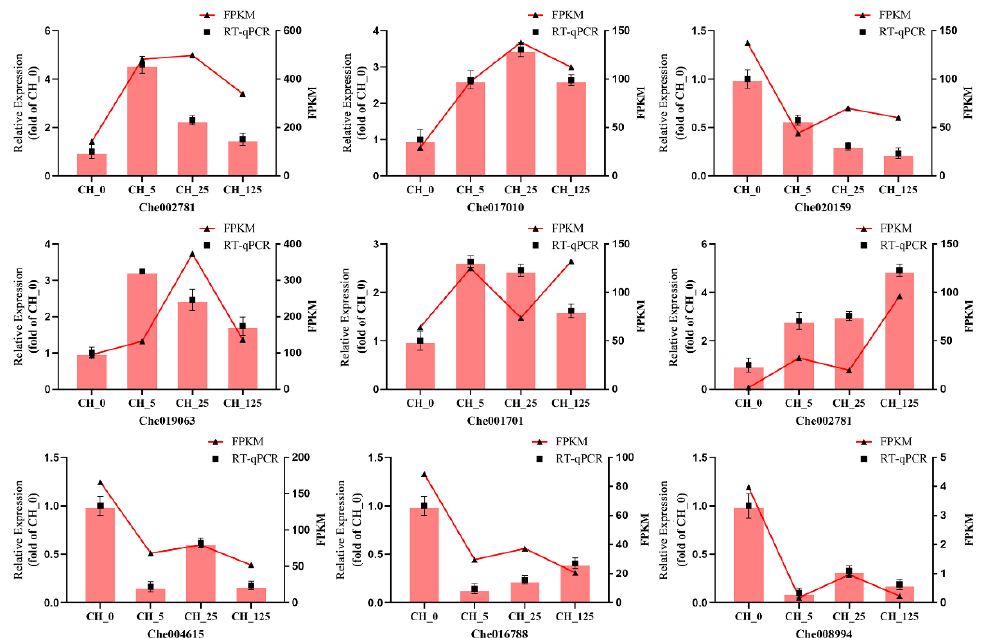
Figure 7. Validation of the expression patterns of differentially expressed genes selected from the RNA-seq analysis by RT-qPCR. The relative gene expression levels determined by RT-qPCR are shown on the left Y-axis, whereas the selected gene expression levels derived by the fragments per kilobase per million reads method are shown on the right Y-axis. The reference gene is GAPDH, and the values represent the means ± standard deviations (n = 3).